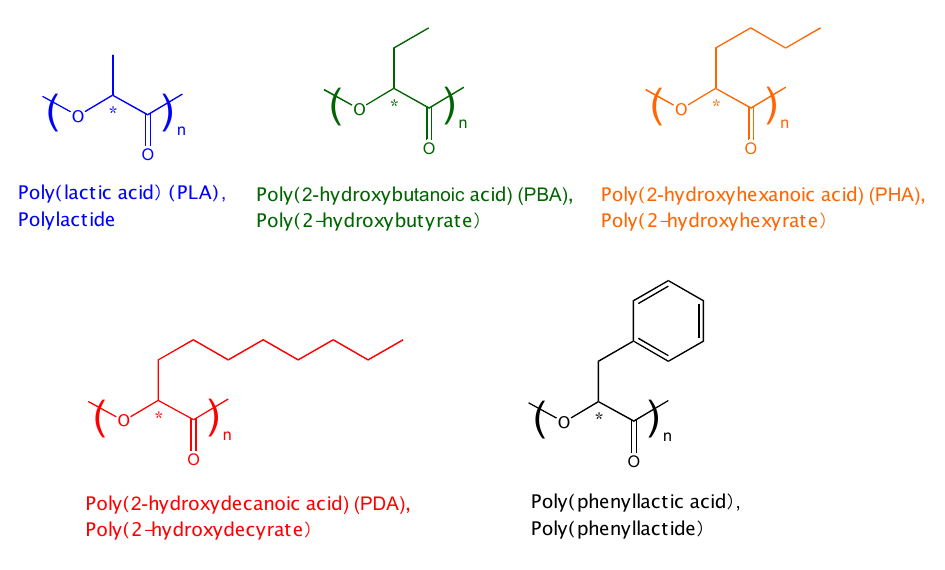
Figure 1. Molecular structures of substituted and non-substituted poly(DL-lactic acid)s